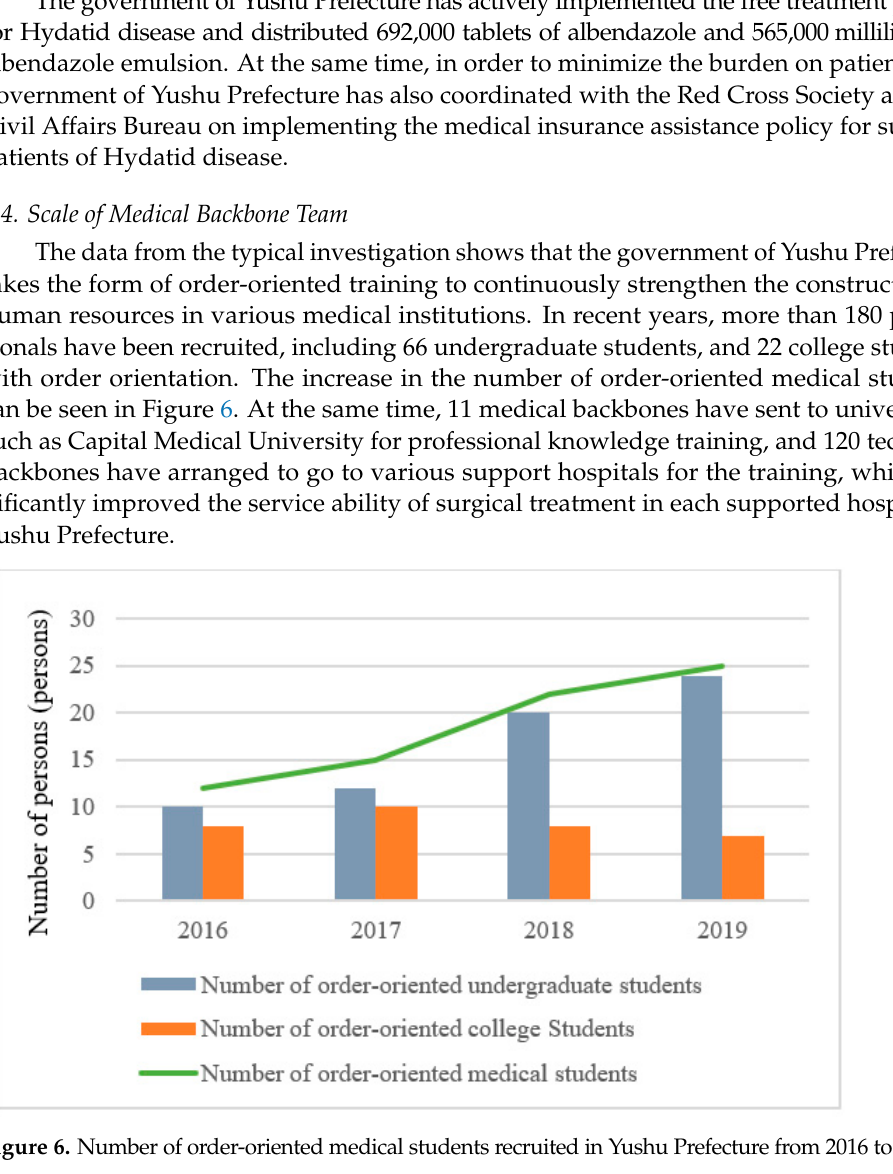
Figure 5. The cumulative number of surgical patients and Hydatid disease screened in Yushu Prefecture from 2016 to 2019.